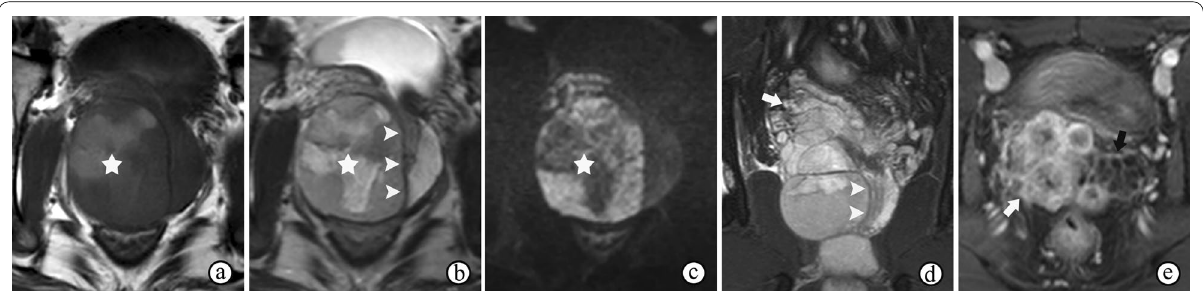
Fig. 14 Synovial sarcoma of the prostate in a 26-year-old man, with a serum prostate-specific antigen level of 1.14 ng/mL. a, b T1-and T2-weighted imaging show a heterogeneous signal mass compressing the prostatic urethra and the left lobe of the prostate, with an incomplete, low T2 signal intensity pseudocapsule (arrowheads on b ) and irregular areas of hemorrhagic and necrotic changes ( ☆ ). c DWI at a b-value of 1200 s/mm 2 shows a high signal intensity of the solid area and low signal intensity of the cystic area of the mass ( ☆ ). d Coronal fat-suppressed T2WI shows the mass compressing the prostatic urethra and the left lobe of the prostate (arrowheads), compressing and invading the right seminal vesicle (arrow). e DCE imaging shows heterogeneous enhancement of the lobulated mass invading seminal vesicles (white arrow). Note the residual tissue of the left seminal vesicle (black